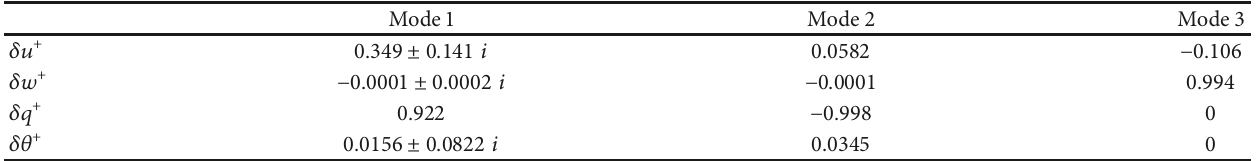
Table 3: Eigenvectors of system matrix.